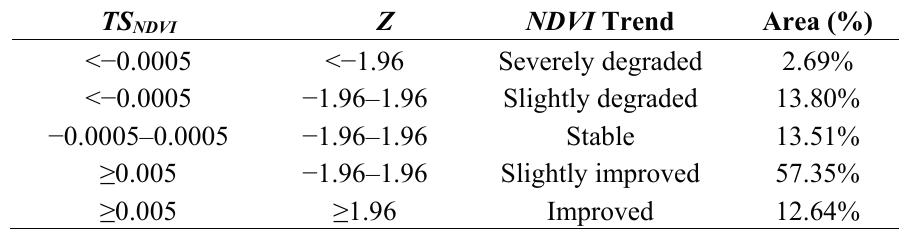
Table 3. Changing trend of normalized difference vegetation index (NDVI) in the study